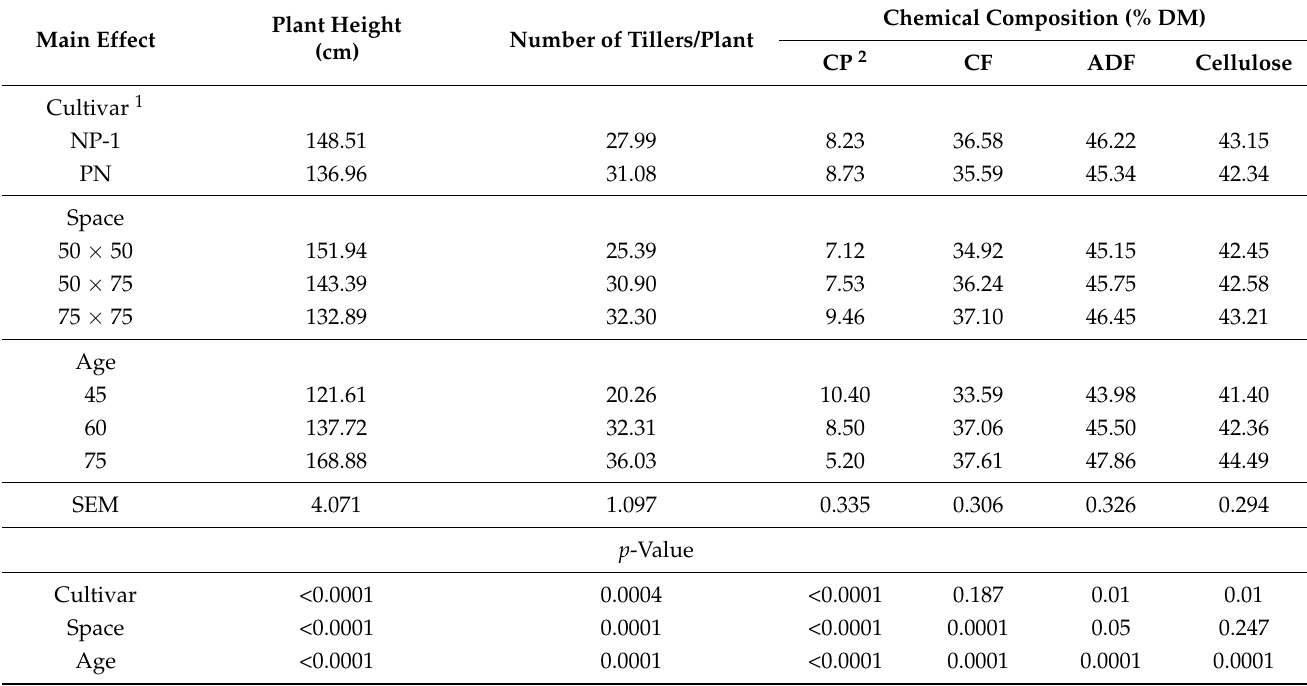
Table 3. The effect of cultivar, plant spacing (cm 2 ), and harvesting age (days) on plant height, the number of tillers/plant, and chemical composition of fresh Napier